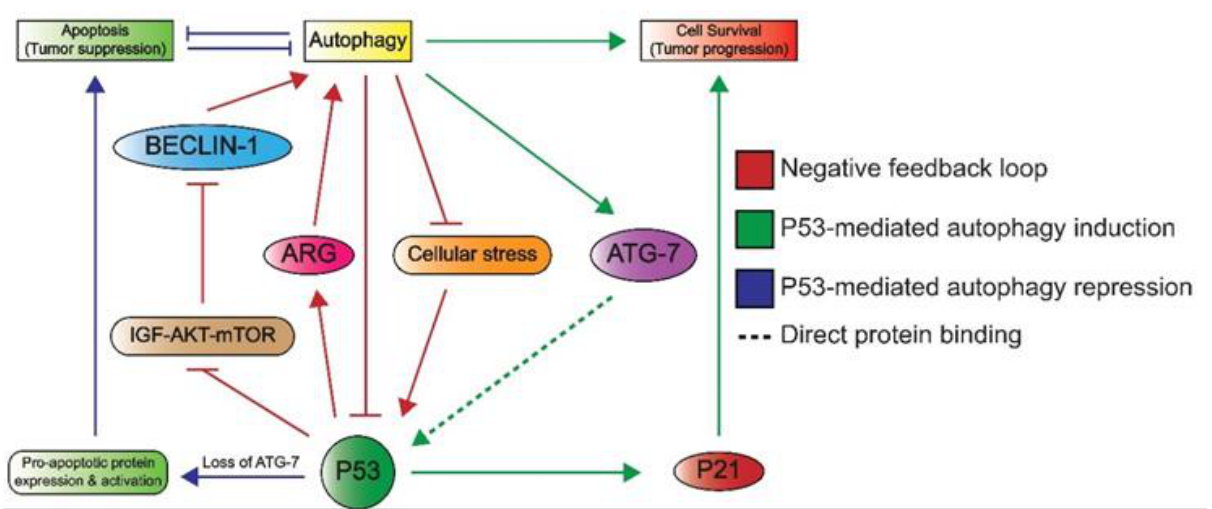
1 Figure 5. An overview of the crosstalk between P53 and autophagy. Autophagy can repress P53 through the inhibition of upstream activating proteins as well as P53 itself. This forms a negative feedback loop (red) as P53 induces autophagy through the inhibition of the IGF – AKT – mTOR pathway and subsequent increase in BECLIN-1 levels, which plays a role in autophagosome formation. P53 also induces the expression of autophagy-related genes (ARG). Autophagy induces cell survival, which is effectuated by the binding of ATG7 to P53, ultimately leading to P53-dependent P21 expression and subsequent cell cycle arrest (green). The loss of ATG-7 results in apoptosis (blue), as P53 induces the expression and activation of pro-apoptotic proteins. Apoptosis and autophagy have mutually inhibitory effects on one another.